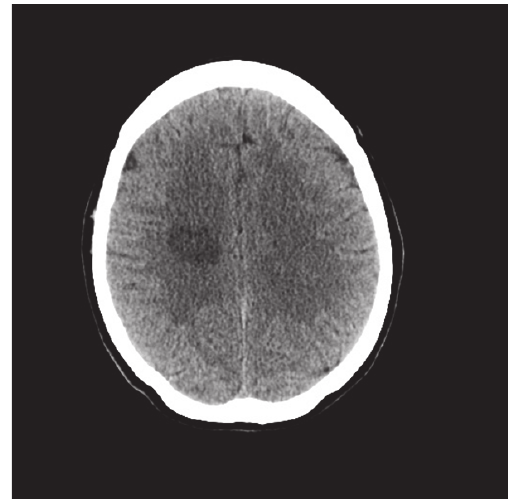
Figure 1: Axial head CT.